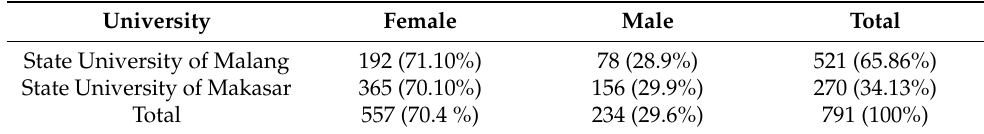
Table 1. The research